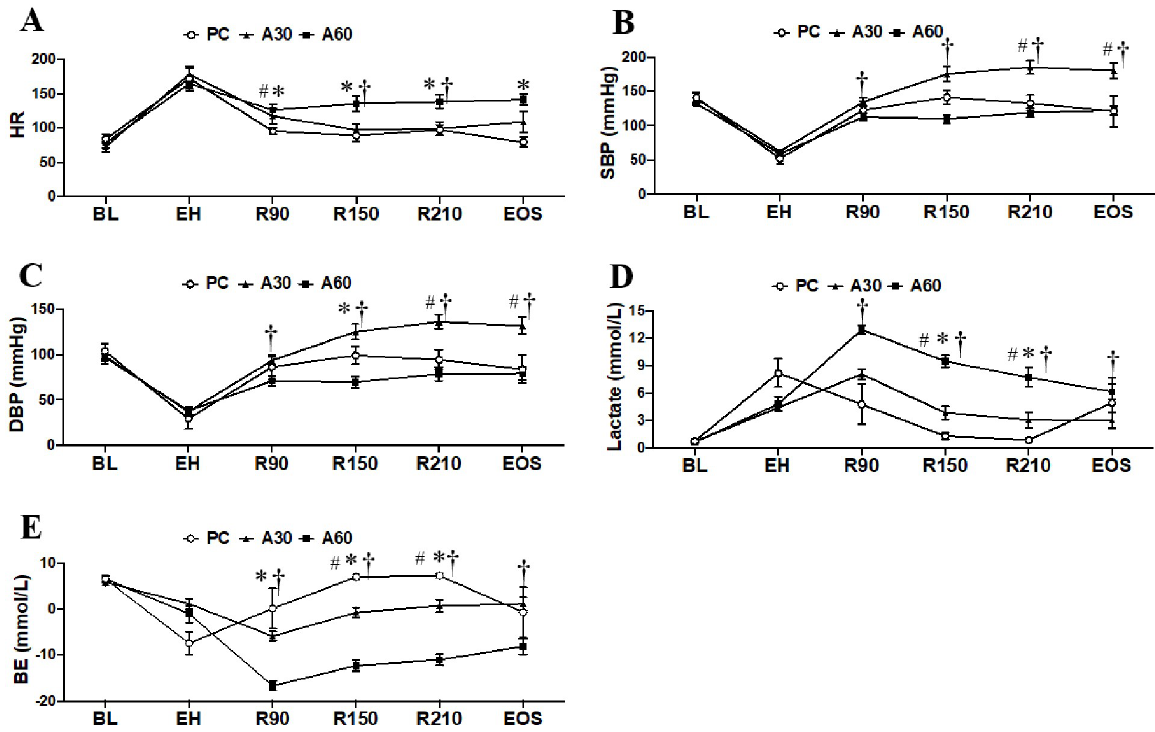
Fig 2. The hemodynamic and metabolic performance of swine undergoing cREBOA. Data are presented as mean ± SEM and were statistically analyzed using two-tailed Mann-Whitney test. # p < 0.05, A30 vs . PC group; � p < 0.05, PC vs . A60 group; † p < 0.05, A60 vs . A30 group. A30, cREBOA for 30 minutes; A60, cREBOA for 60 minutes; DBP, diastolic blood pressure; PC, positive control. BE, base excess; EOS, end of study; HR, heart rate; SBP, systolic blood pressure.